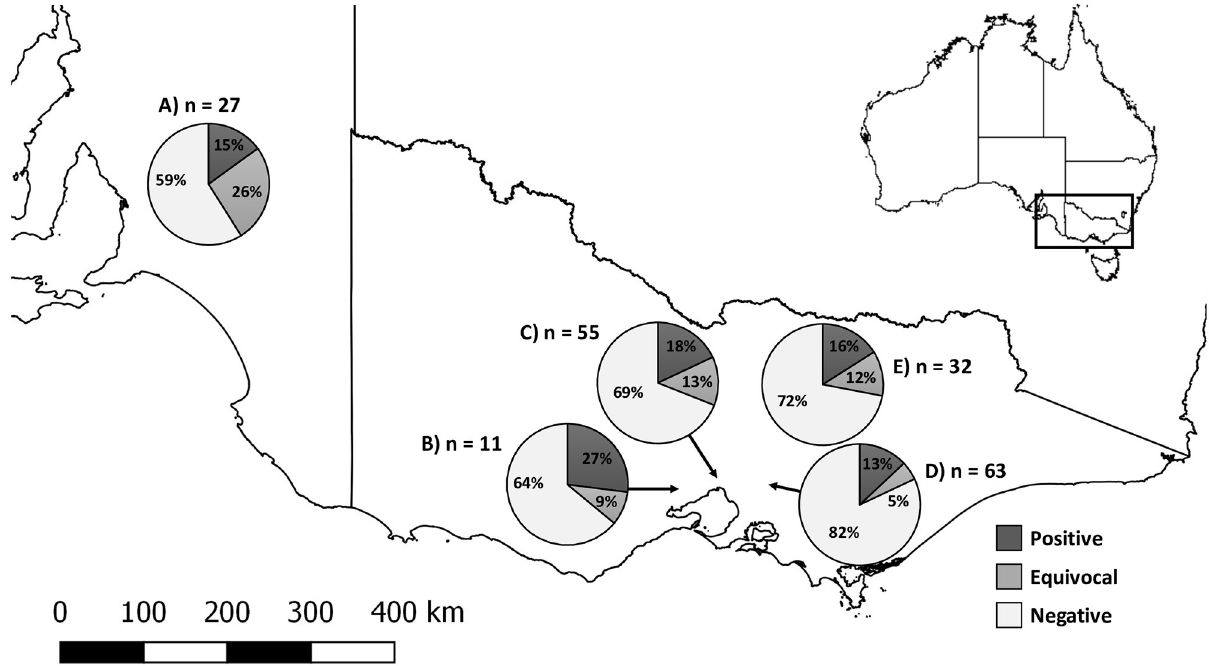
Fig 2. Geographical distribution of sampled possums that were seropositive or suspect seropositive for WPDV in Australia. Sera (n = 188) originated from five regions in the states of Victoria and South Australia: A- Adelaide; B—Werribee; C—Melbourne zoo; D—the eastern suburbs of Melbourne and the Yarra Valley; E—Strathbogie mountains. Seropositivity for wobbly possum disease virus (WPDV) was defined by a corrected OD > 0.41 and suspect positives (equivocal) by a corrected OD 450 > 0.28. Base maps and state boundaries were sourced from GEODATA TOPO 250K Series 3 (Geoscience Australia; http://pid.geoscience.gov.au/dataset/ga/64058 accessed 28 July 2019) and reproduced under Creative Commons Attribution License 4.0.